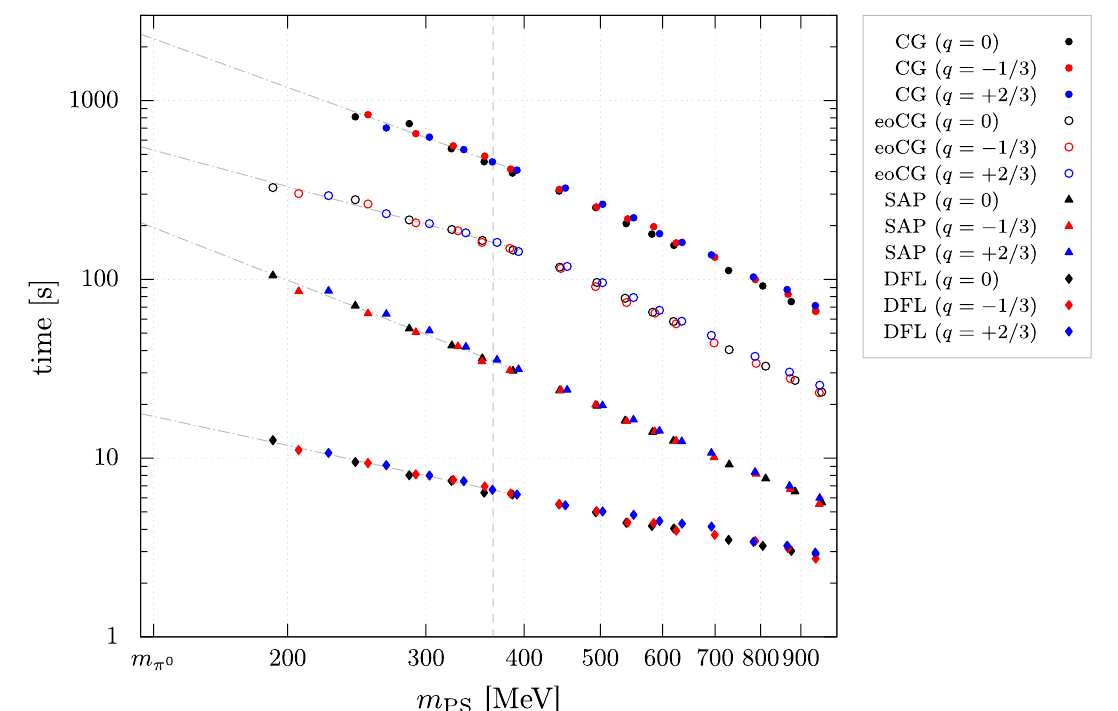
Fig. 6 Comparison of performance of various solvers and various electric charges as a function of the mass m PS of the valence neutral pion. In all cases, the inverse of the even–odd preconditioned Dirac operator has been calculated on random sources. One representative QCD+qQED configuration has been used (SU(3) configuration from